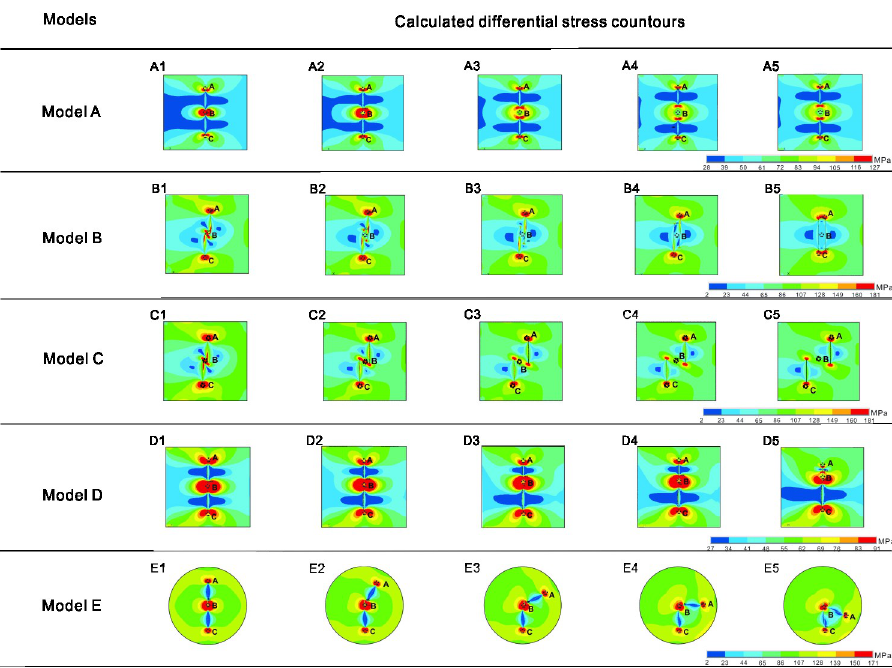
Fig 2. Differential stresses (measured in MPa) calculated by the four groups of models. Black circles denote points A, B and C in each model, where the differential stresses are shown in the curves in Fig 3.